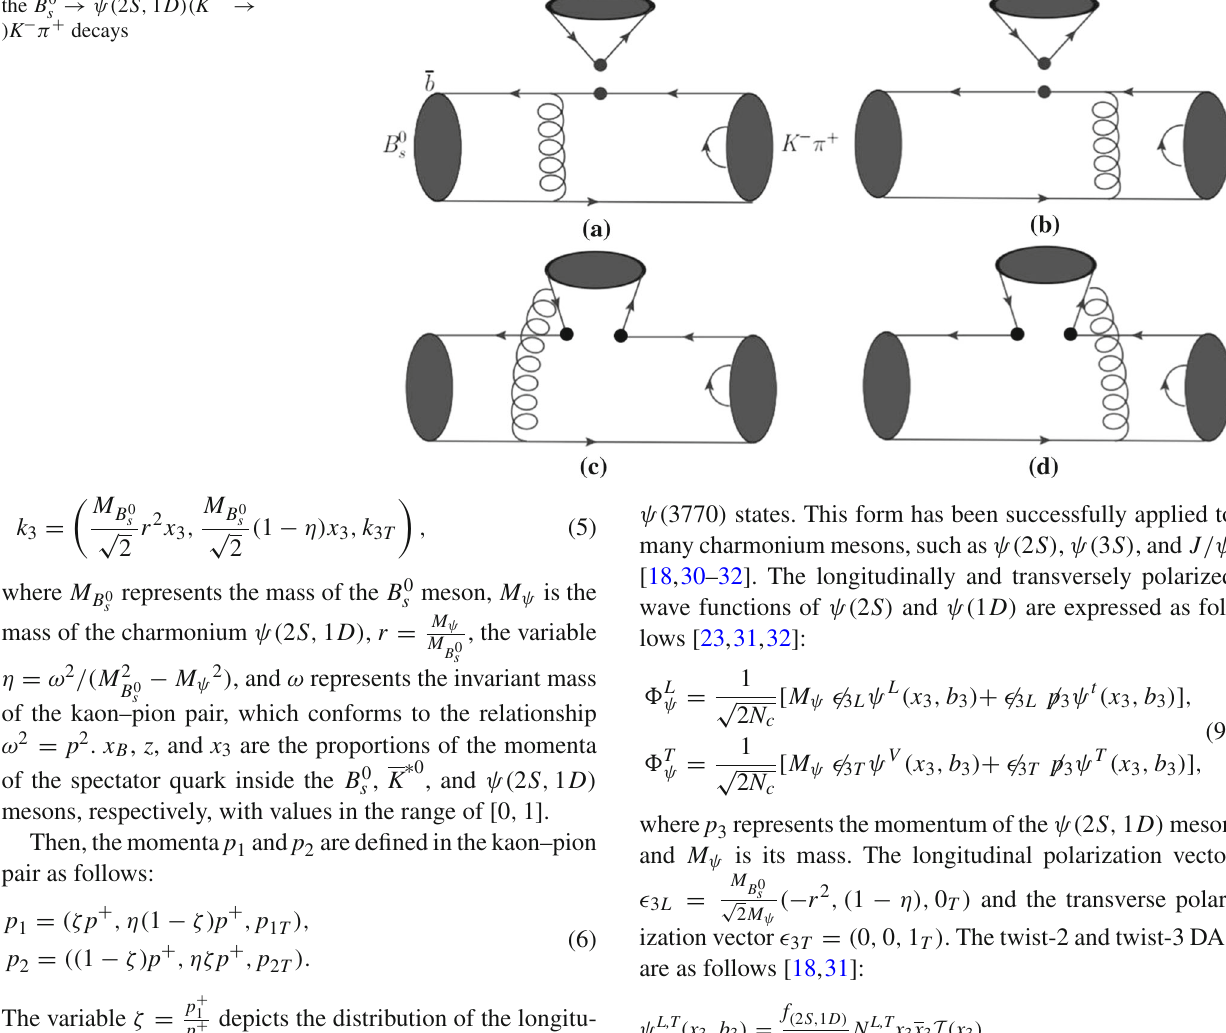
Fig. 1 Feynman diagrams of the B 0 s → ψ( 2 S , 1 D )( K ) K − π + decays